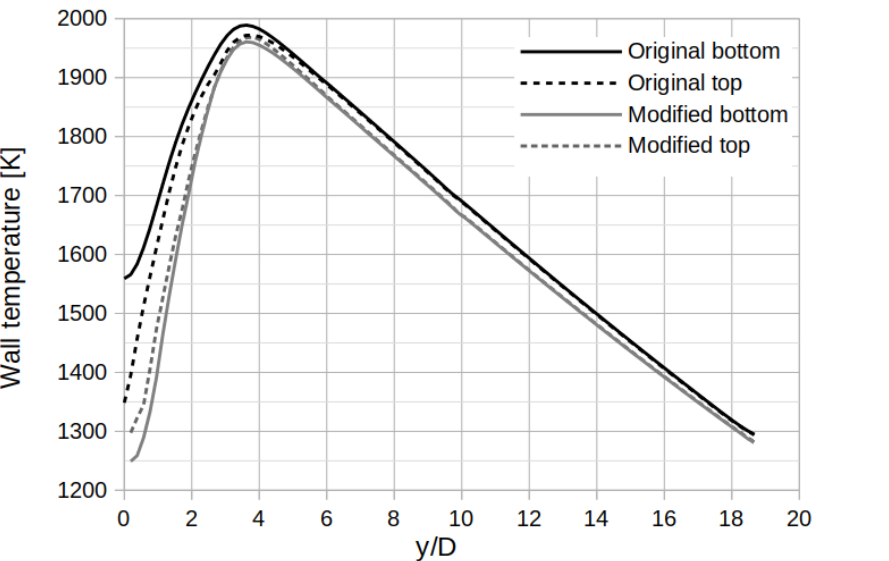
Figure 8. Computed top and bottom wall temperature in K along the axis of the kiln with the original rectangular and modified annular secondary air inlet with volumetric air–fuel ratio set equal to